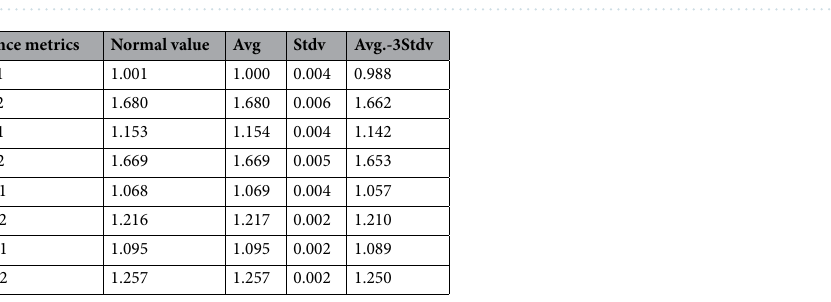
Figure 7. Frequency distribution of PPSTE of each gear pair using random robustness analysis.